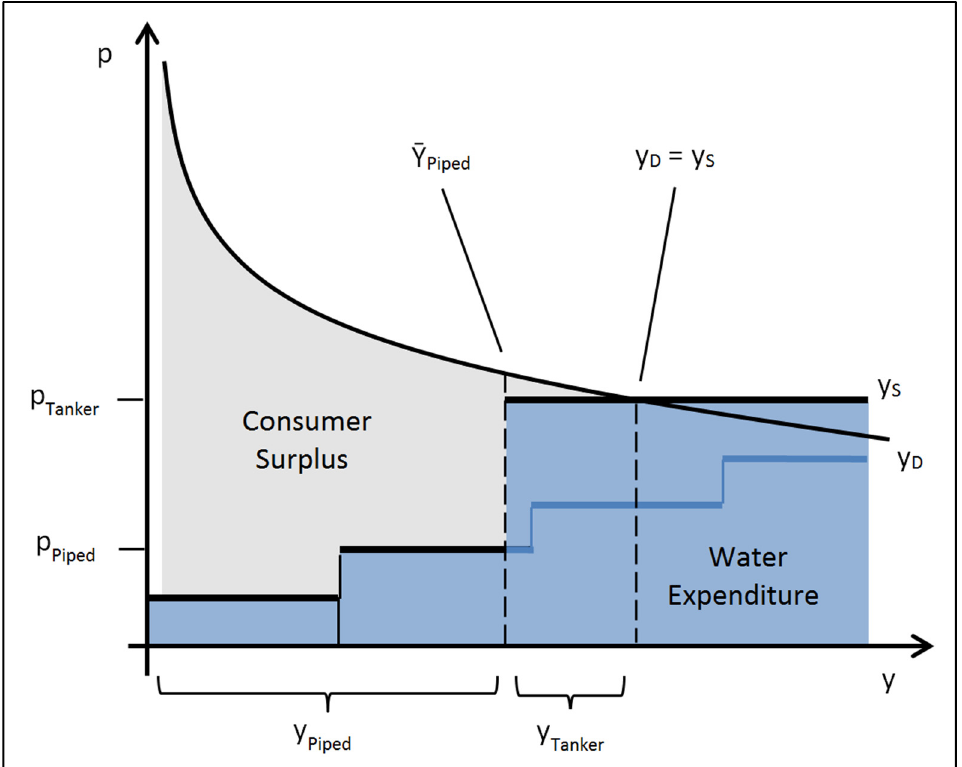
Figure 1. Illustration of the “tiered supply curve” model for one household buying a constrained quantity of piped water charged according to an increasing block tariff and private tanker water sold at a constant price, based on Srinivasan et al. [20] (p = price, y = water quantity, D = demand, S = supply, Ῡ = maximum individual piped water availability). The consumer surplus area is marked in gray, the water expenditure area in blue. The blue line represents the piped water tariff blocks that are not relevant to the household, since they lie beyond its piped water constraint. Bottled water purchases for drinking purposes are assumed to be constant and are not explicitly included in the